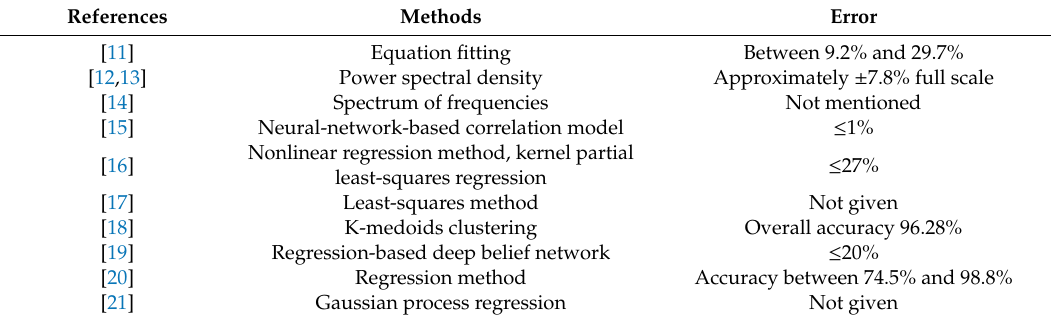
Table 1. Comparison of di ff erent prediction methods for the valve internal leakage